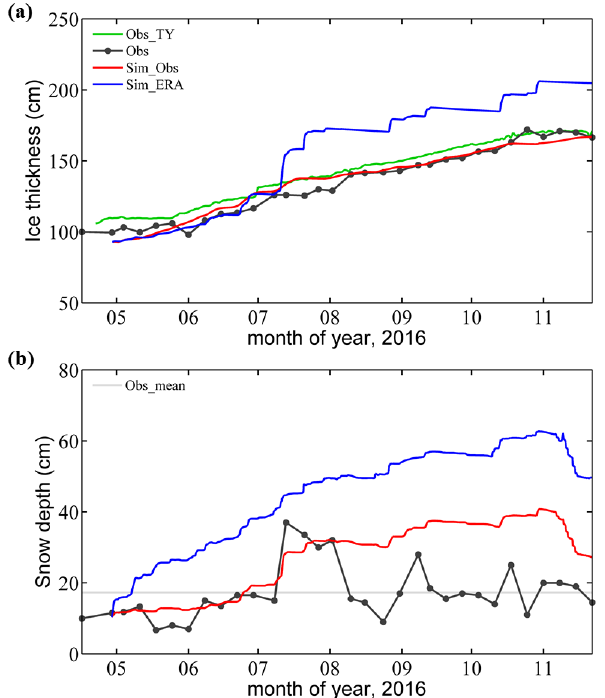
Figure 3. Time series of (a) sea ice thickness and (b) snow depth during the freezing season. Solid black lines with black points show the observations from the drill hole (Obs). Solid green lines show the ice thickness derived from the TY buoy (Obs_TY). Solid red lines show the simulation results under in situ atmospheric forcing (Sim_Obs), and solid blue lines are simulation results under ERA5 forcing (Sim_ERA). In (b) , the solid gray line shows the seasonal mean snow depth observations